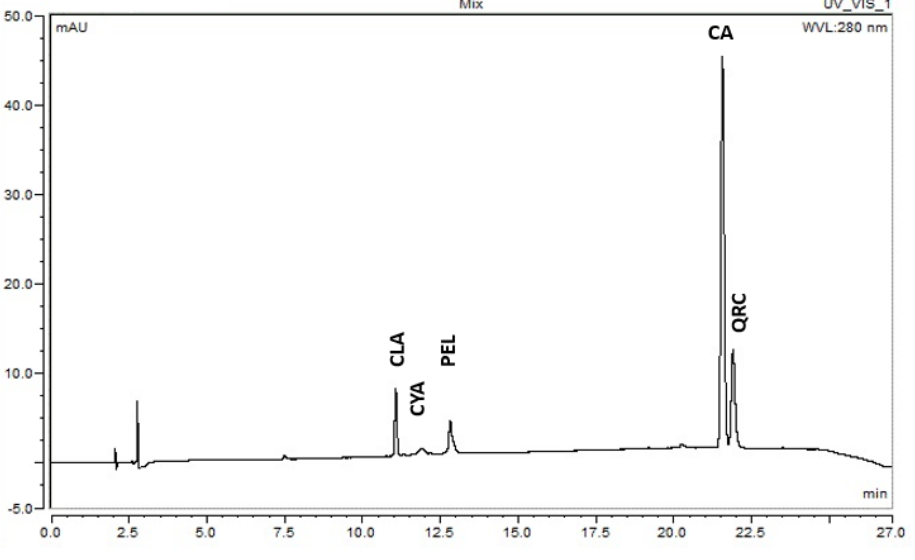
Figure 2. HPLC chromatogram obtained from the calibration curve in the analysis of the mixture of standards used: CYA (Cyanidin 3-glucoside), PEL (Pelargonidin 3-glucoside), CA (Cinnamic acid), QRC (Quercetin) and CLA (Chlorogenic acid).